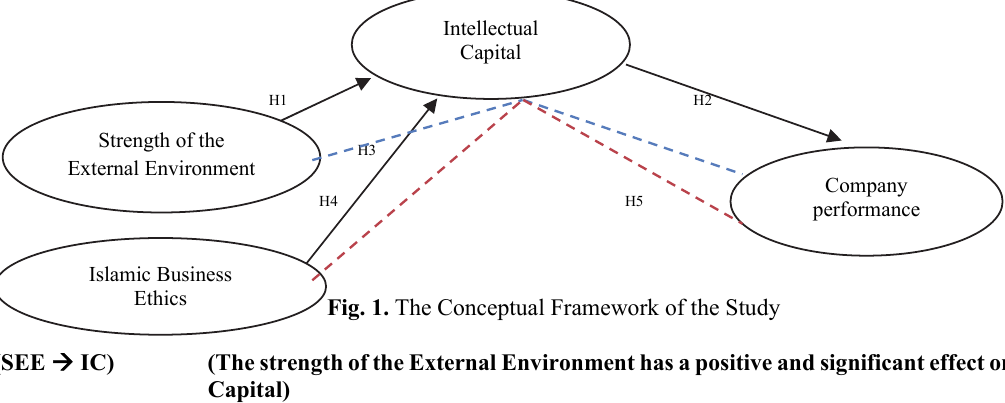
Fig. 1. The Conceptual Framework of the